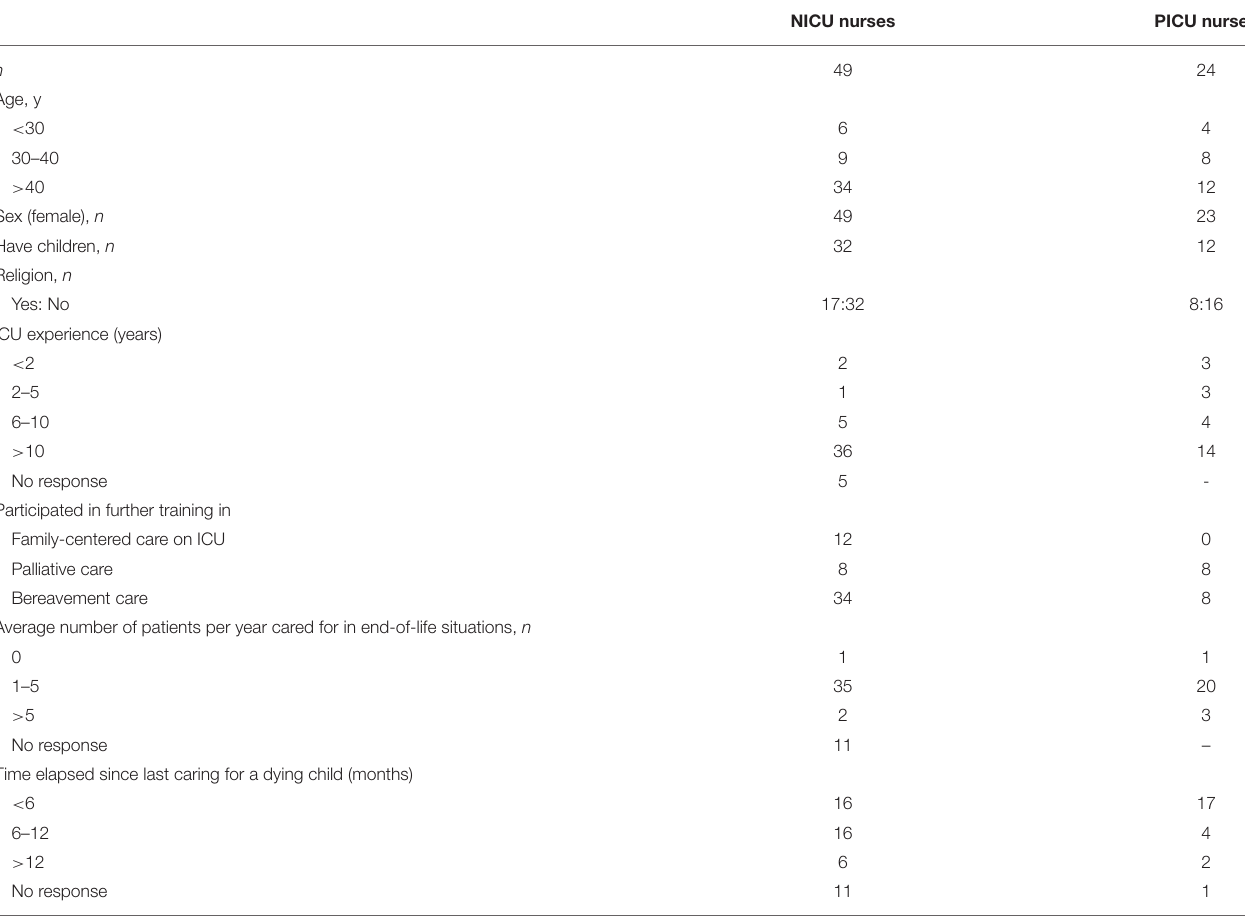
TABLE 1 | Descriptive statistics of intensive care nurse